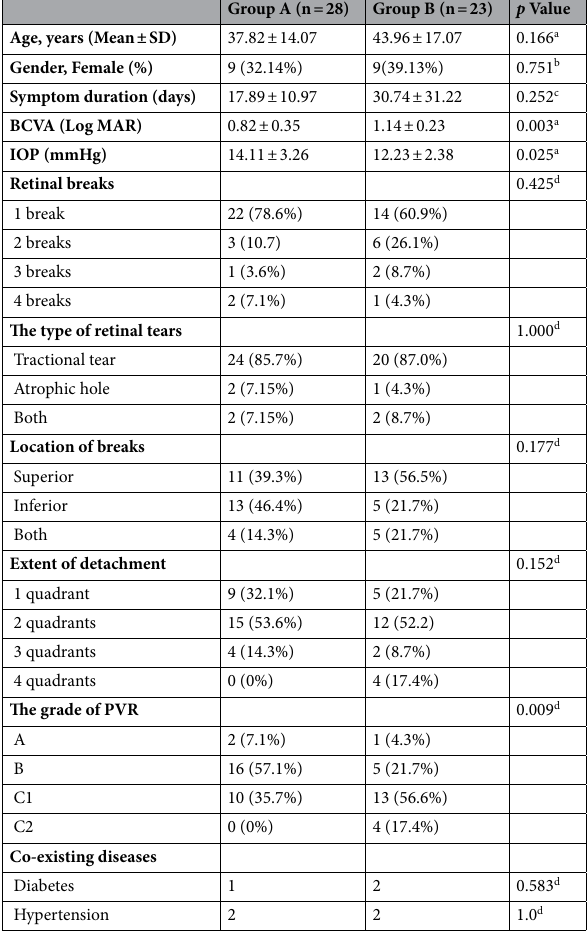
Table 1. Patients’ demographic and preoperative clinical characteristics. a t -test. b Chi-square test. c Mann- Whitney U test. d Fisher exact test, Abbreviation: BCVA, Best Corrected Visual Acuity; IOP, Intraocular Pressure; PVR, Proliferative